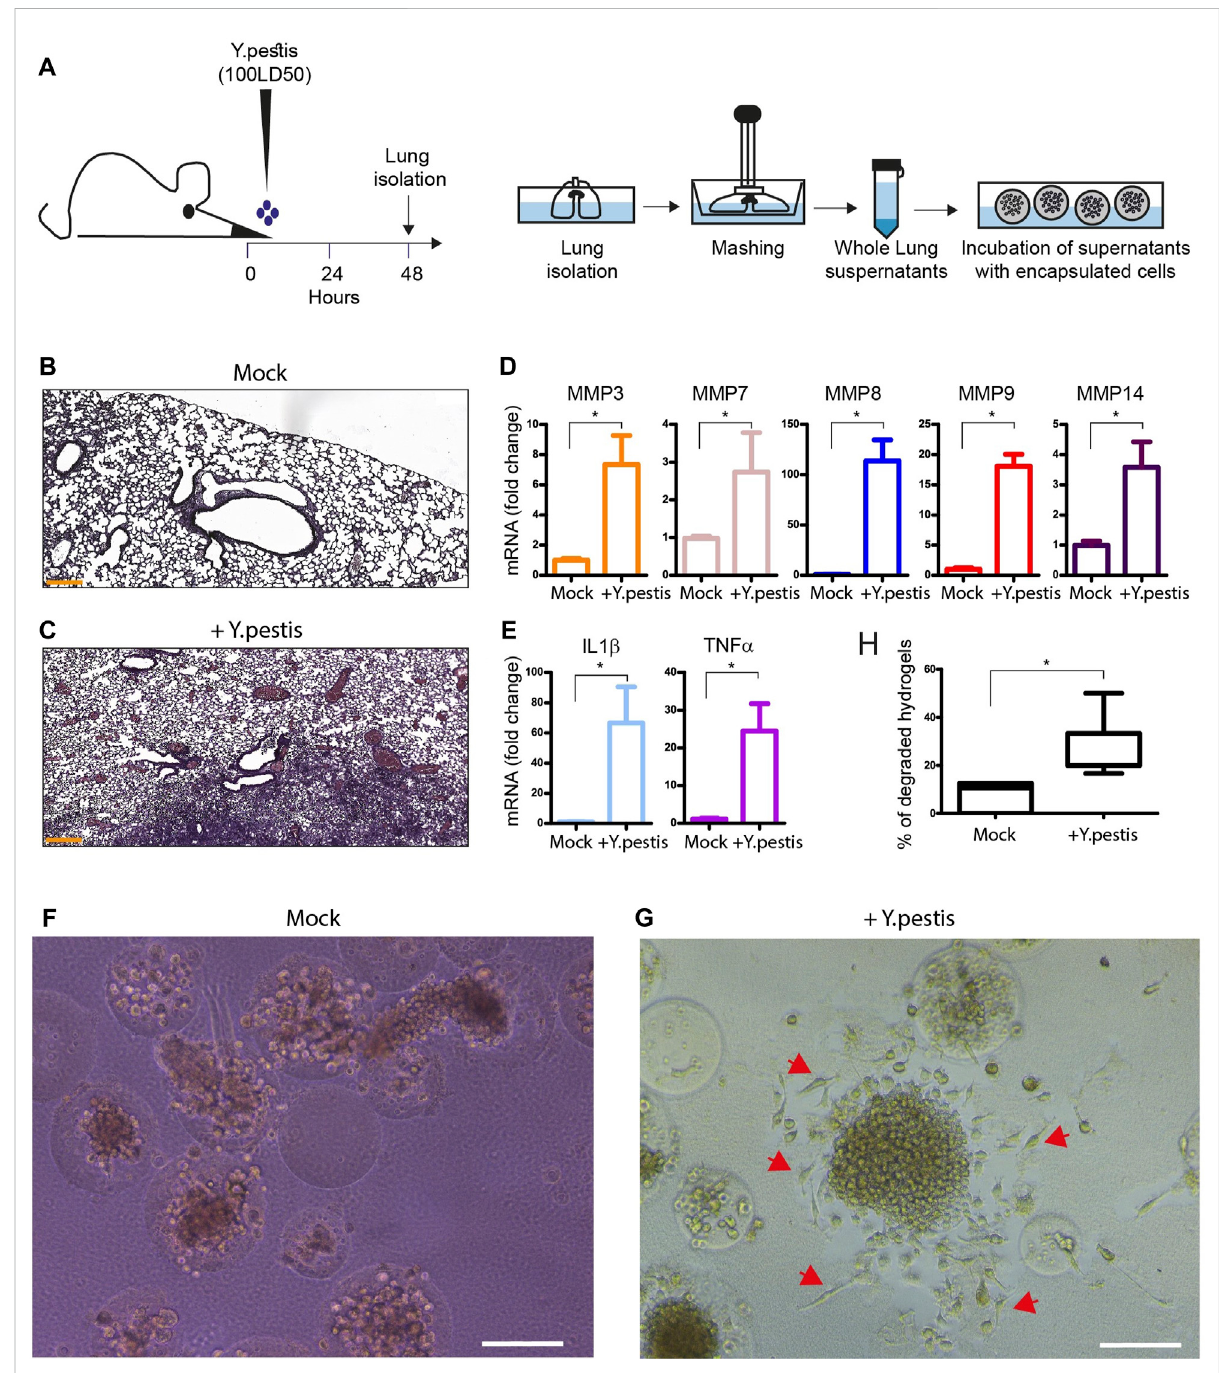
FIGURE 5 Ex vivo incubation of microspheres with Y. pestis infected whole lung extracts. (A) An illustration of the experimental design showing intranasal administration of a dose of 100LD 50 (110,000 CFU) of Y. pestis bacteria (Kim53 strain). After 48 h, the mice were sacri fi ced, and the lungs were isolated. Isolated lungs were mashed and the whole lung supernatants were fi ltered and transferred to cultures of encapsulated macrophages in microspheres. (B,C) Hematoxylin and eosin staining of lung sections from representative mock (B) and Y. pestis -infected mice (C) , 48 h post infection. (D,E) Bar plots showing mRNA expression (fold change) of metalloproteases MMP3, 7, 8, 9 and 14, as well as, IL1 β and TNF α cytokines in mock or Y. pestis -infected (+Kim53) lungs, 48 h post infection. (F,G) Bright fi eld images of encapsulated macrophages in microspheres after 7 days incubation with mock extract (F) or Y. pestis -infected lung extracts (G) . (H) Box plot showing the percent of degraded hydrogels in incubation with mock- and Y. pestis -infected lung extracts. Results are presented as median percentiles of degraded hydrogels analyzed from 12 different